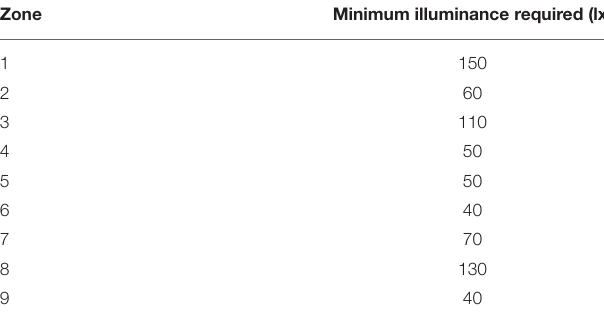
TABLE 2 | Lighting requirement in each